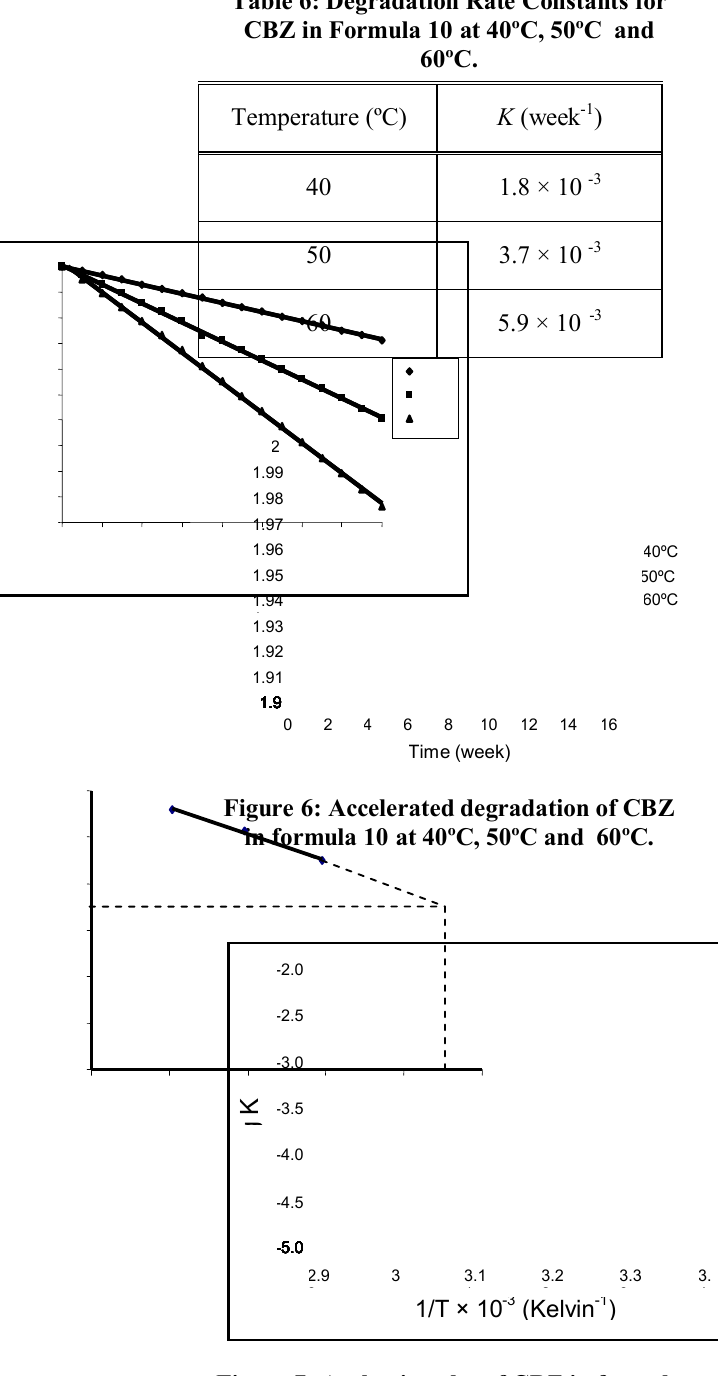
Figure 7: Arrhenius plot of CBZ in formula 10 for the estimation of the expiration